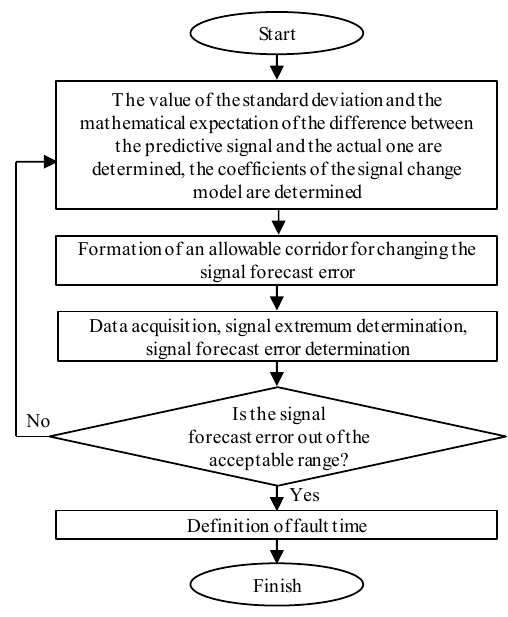
Figure 2. The block diagram of the algorithm 2. Algorithm 2 is based on estimating the signal forecast error on the forestall interval.